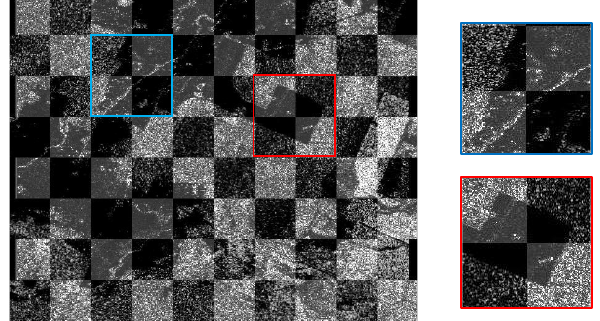
Figure 11. The Chessboard Diagram for Yamba Image.